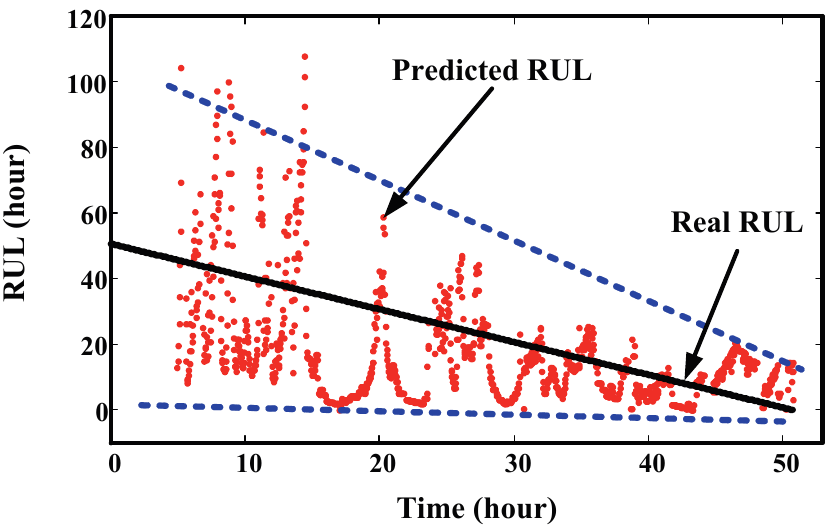
Figure 22. Comparison of predicted RUL values with real RUL values at different inspection time